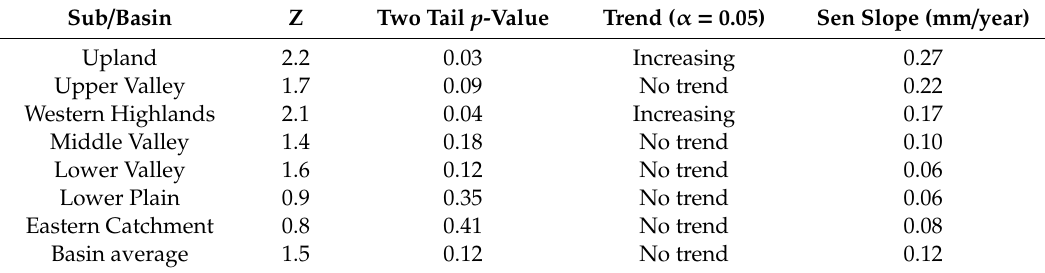
Table 6. Summary trend analysis for winter rainfall.